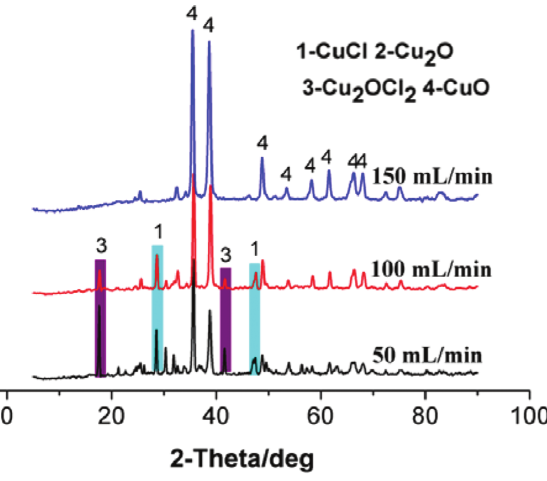
Figure7: XRD patterns of the roasted samples at 450°C for 90 min under different oxygen flow